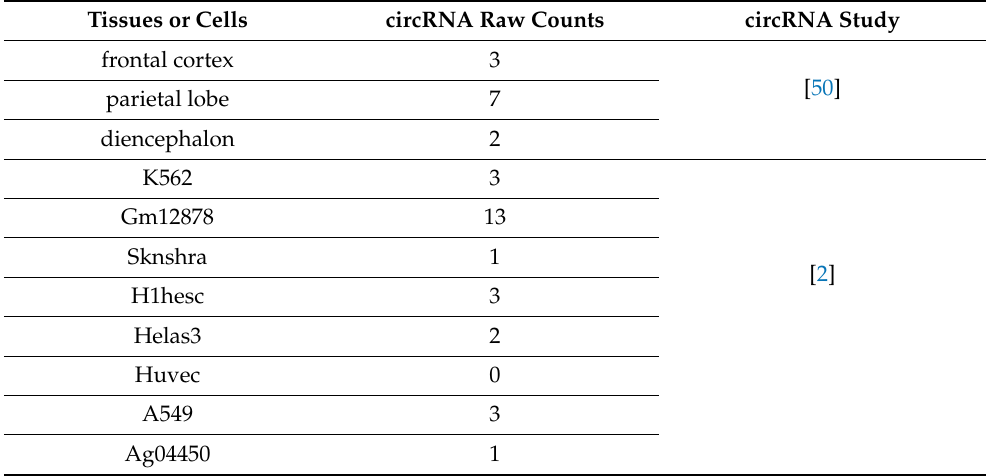
Figure 7. ( A ) CircRNA abundance relative to mRNA in total RNA. ( B ) Circular junction reads (in the yellow box region) only represent a small portion of the entire circRNA. The reads from other parts of the circRNA body (arrowed region) are indistinguishable from that of the linear RNA counterparts. Table 7. Low raw counts of a randomly picked circRNA hsa_circ_0054254 in various tissues and cells in the circRNA